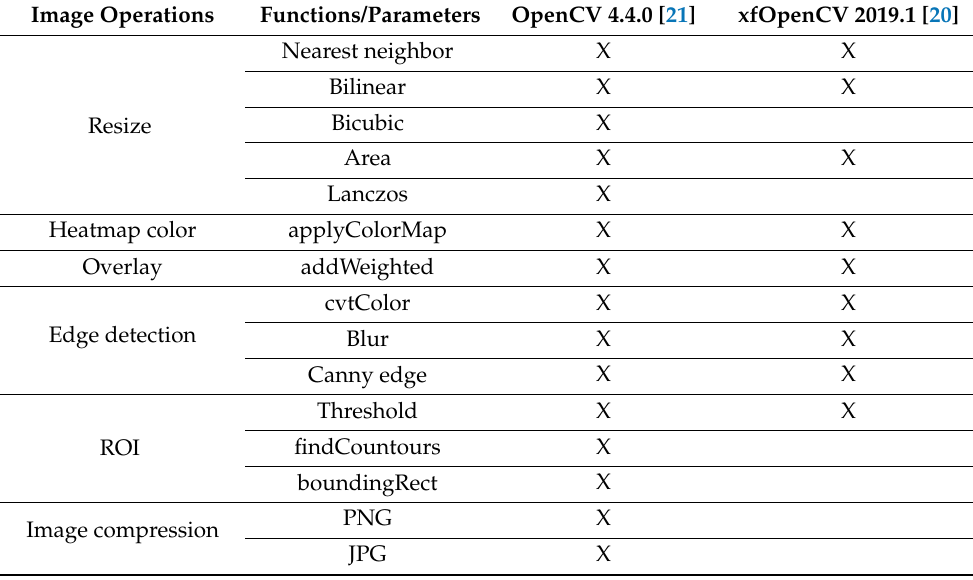
Table 2. Comparison of supported image operations in OpenCV 4.4.0 and xfOpenCV 2019.1